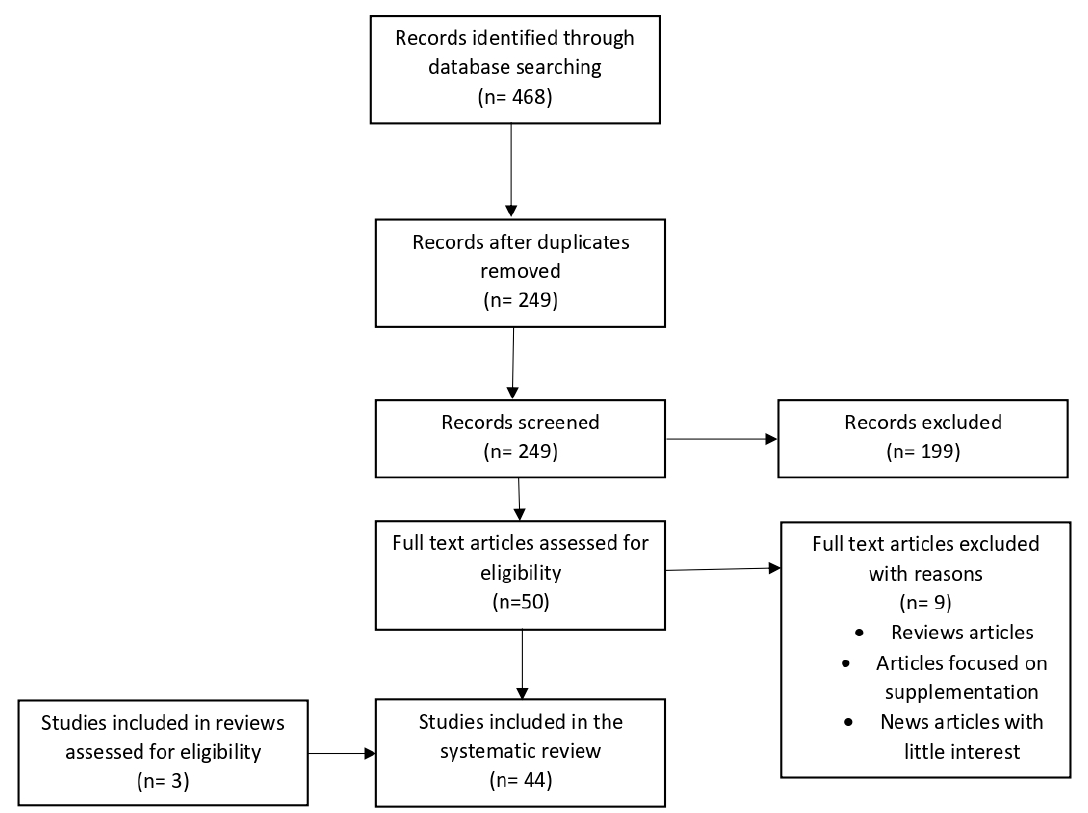
Figure 1. Study retrieval process flowchart.